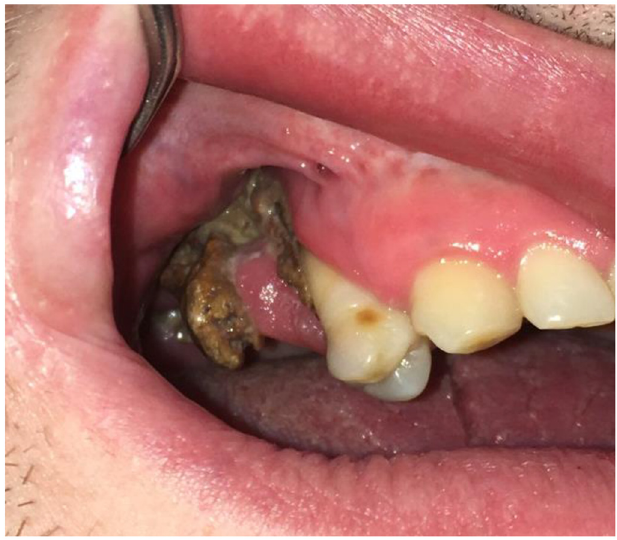
Image 1. Intraoral examination of sector 1. The intraoral examination revealed bone exposure of necrotic tissue distal to 14.